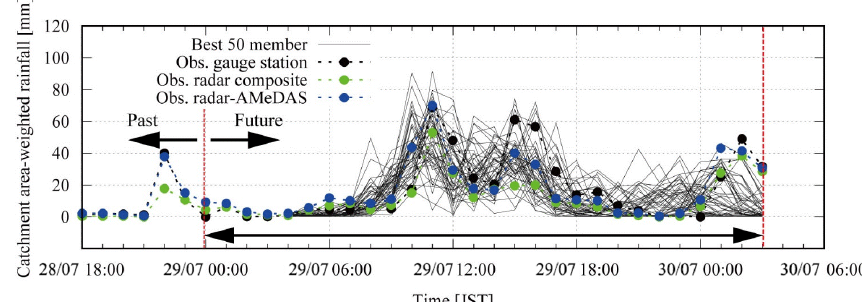
Figure 11. Rainfall intensity of the 50 best ensemble inflow simulation members, of radar–AMeDAS, of radar composite and of ground